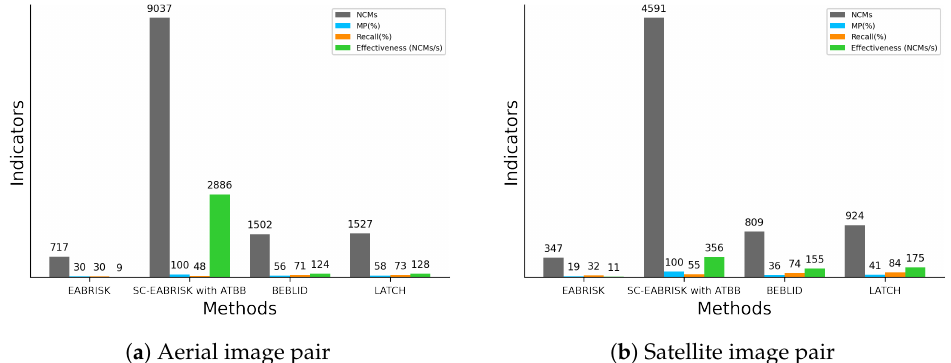
Figure 11. Numerical analyses of the image matching results by using aerial and satellite image